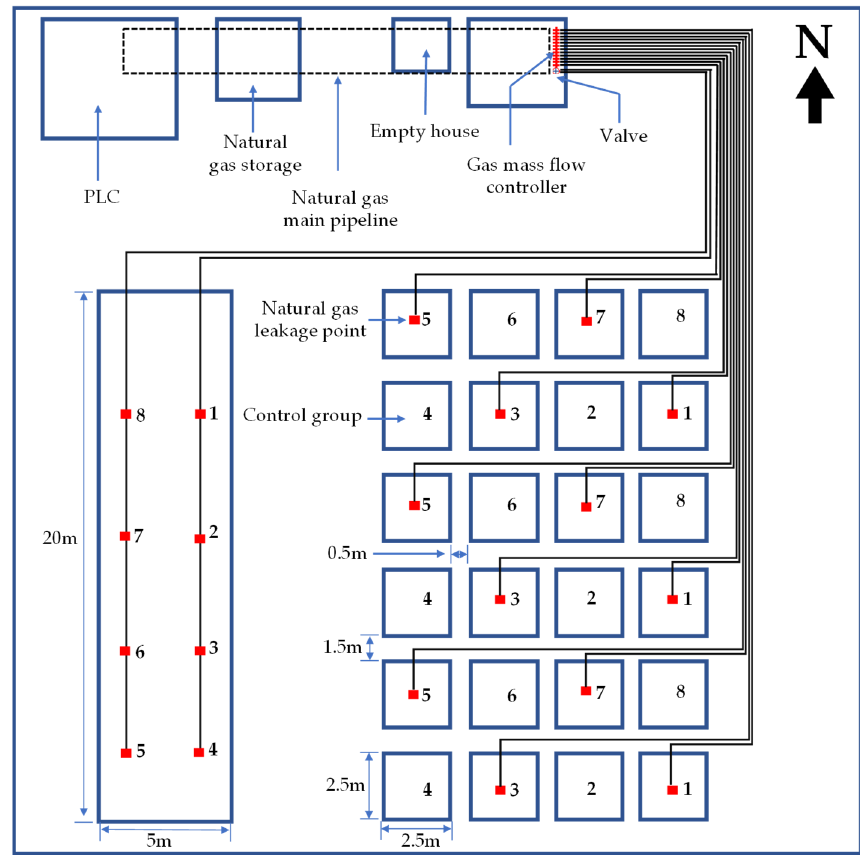
Figure 1. The sketch map of the experimental area; the numbers in a 20 m × 5 m plot are marked leak point, and the 2.5 m × 2.5 m plots with odd numbers represent the experimental plots whereas these with even numbers represent control plots without natural gas.